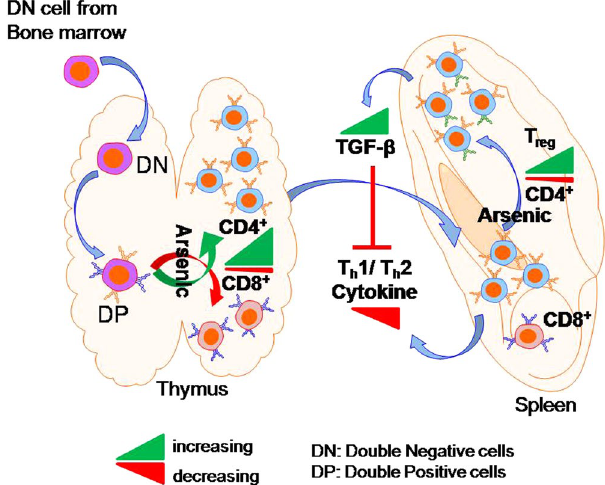
Figure 9. Schematic representation of arsenic-induced T reg cells mediated immnosuppression. Exposure to arsenic promoted commitment of DP cells into CD4 + T cells in thymus. Simultaneously arsenic enhanced differentiation of splenic CD4 + T cells into T reg cells. Increased T reg cells secreted high amount of TGF- β which subsequently inhibited